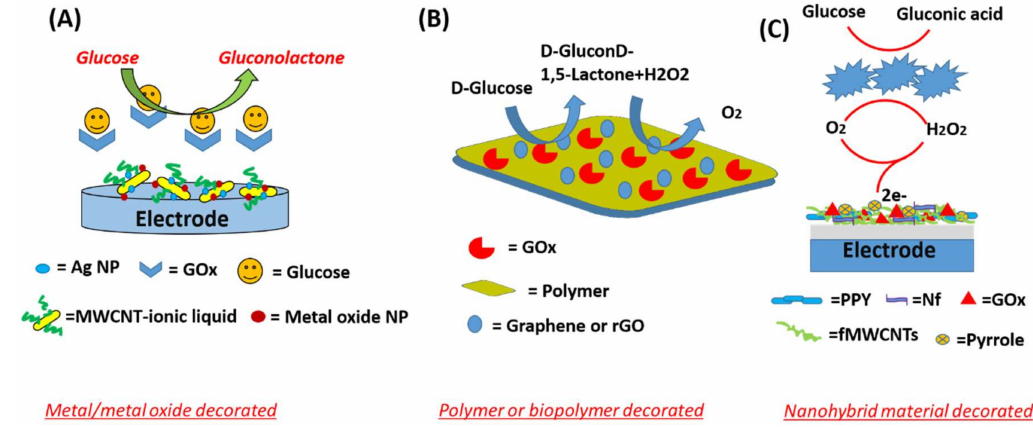
Figure 4. Illustration of types of carbon-based nano-hybrid and nano-composite materials in electrochemical glucose biosensors ( A ) AgNP/MWCNT; ( B ) rGO/Polymer and ( C )